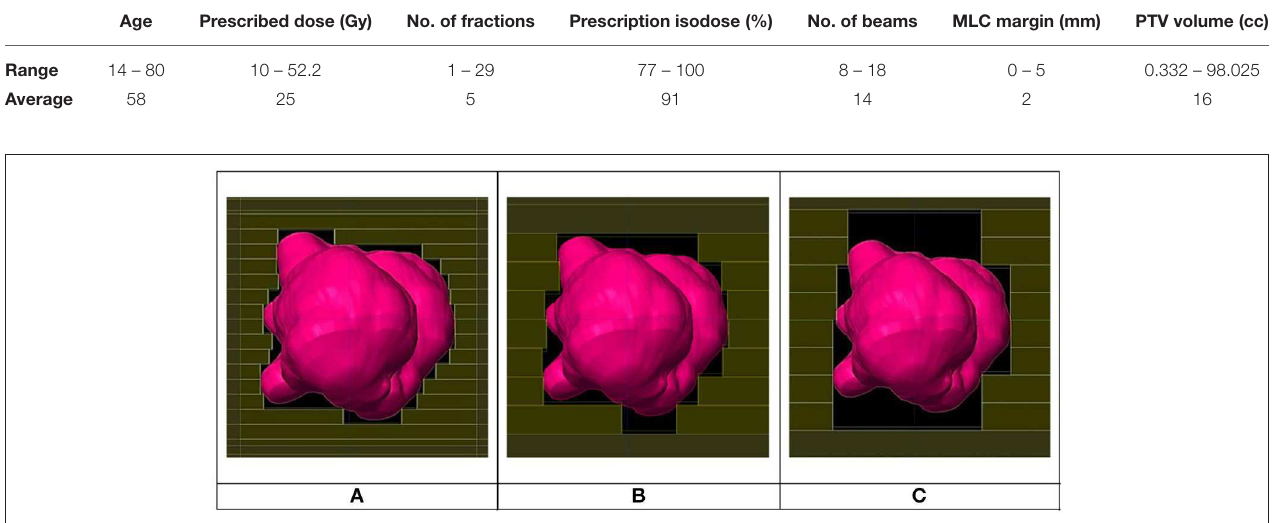
V isod : Volume of prescription isodose cloud (20 Gy cloud) V ∩ : V PTV ∩ V isod